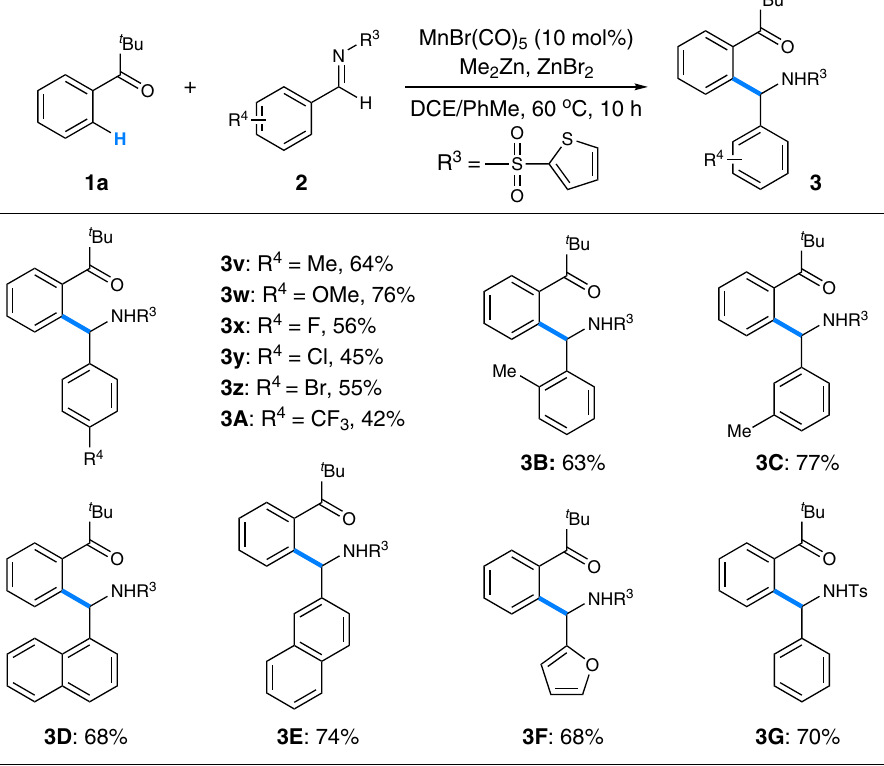
Fig. 4 Scope of imines for the mono -C – H addition reaction. Reaction conditions: 1a (1.5 mmol), 2 (0.5 mmol), MnBr(CO) 5 (0.05 mmol), Me 2 Zn (0.75 mmol, 1.2 M in toluene), ZnBr 2 (0.5 mmol), DCE (0.4 M), 60 °C, 10 h. DCE 1,2-dichloroethane